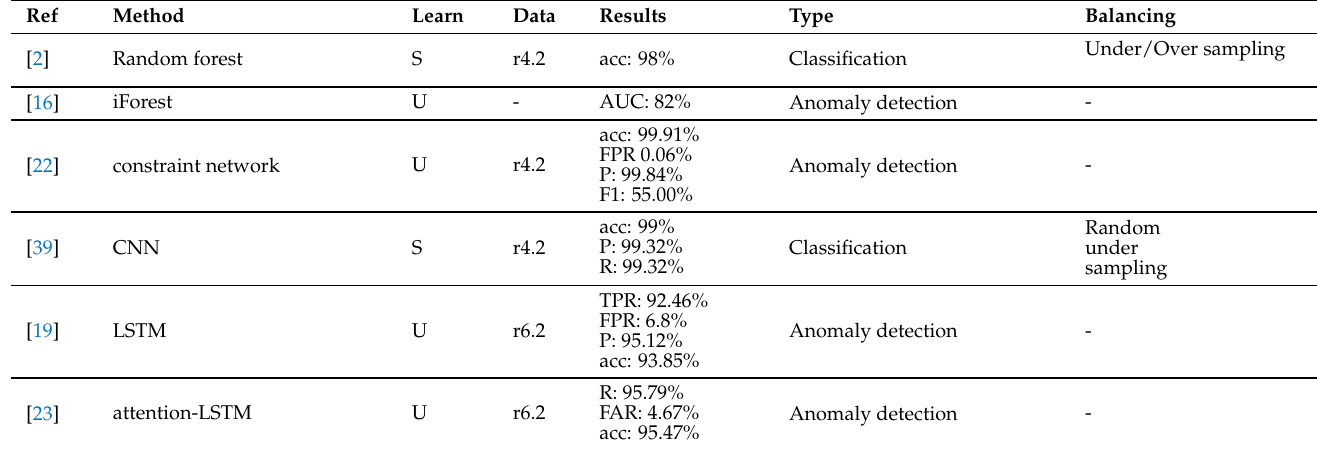
Table 1. Literature review summary. Abbreviations: Accuracy (acc), False Positive Rate (FPR),